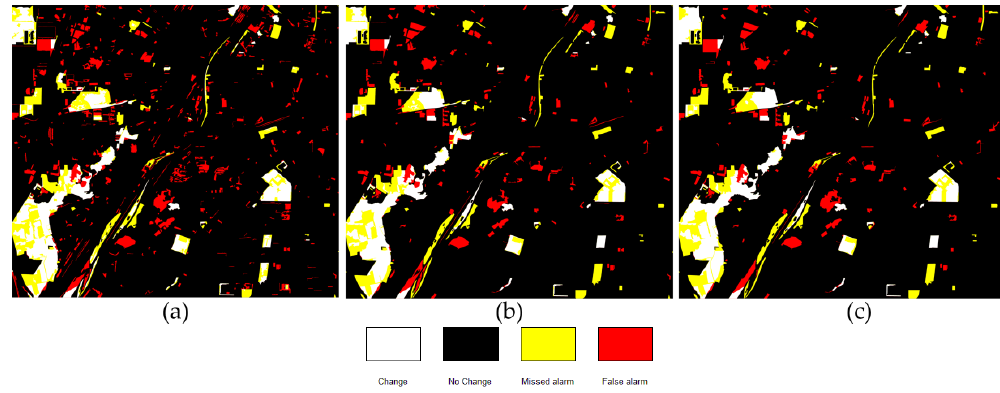
Figure 16. CD results for DS2. ( a ) RoF (Scale 136); ( b ) RoF (Scale 206); ( c ) RoF (Scale 244).